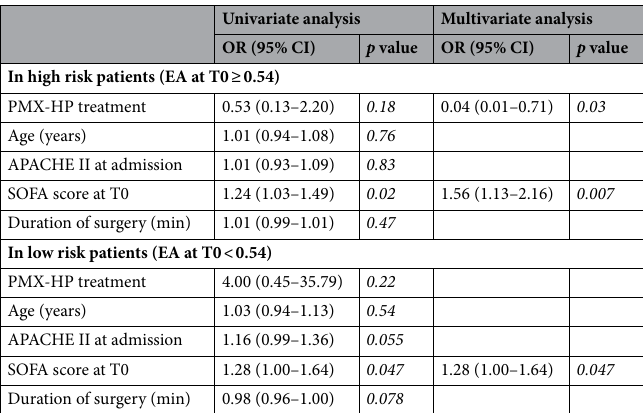
Univariate analysis Multivariate analysis OR (95% CI) p value OR (95% CI) p value In high risk patients (EA at T0 ≥ 0.54) PMX-HP treatment 0.53